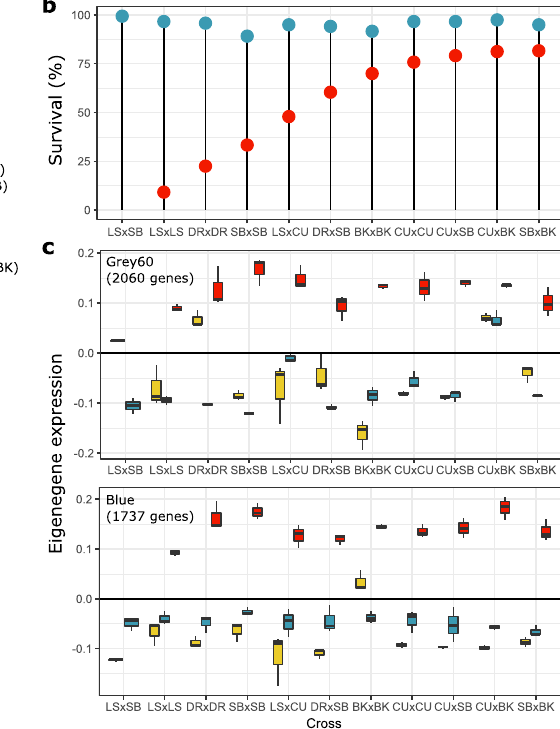
Fig. 1 | Larval gene expression responses to heat stress in genetically distinct crosses. a Discriminant analysis of principal components (DAPC) with heat treatment symbolized by color and cross ID symbolized by shape. The fi rst linear discriminant axis separates the heat treatments, 27°C for “ pre ” ( n =33 pools of 10 larvae each) and “ post ambient ” ( n =33 pools of 10 larvae each), 35.5°C for “ post heat ” ( n =30 pools of 10 larvae each), with density plots showing the distribution of samples in each cross and treatment along LD1,